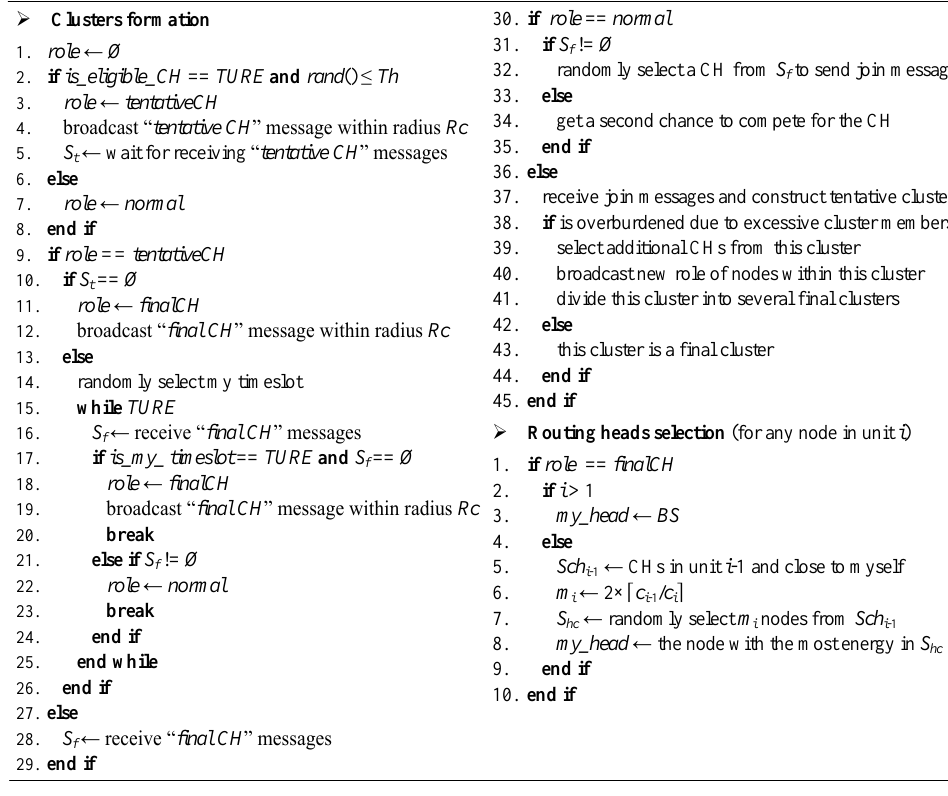
Figure 4. Topology formation phase pseudo code in Multi-hop Energy Neutral Clustering (MENC).